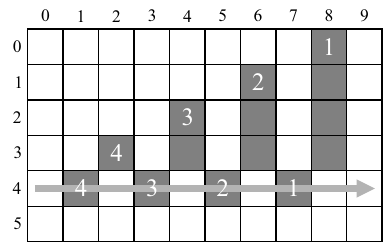
Figure 2. A chain of successive mergers: 4 ⇒ 3; 3 ⇒ 2; 2 ⇒